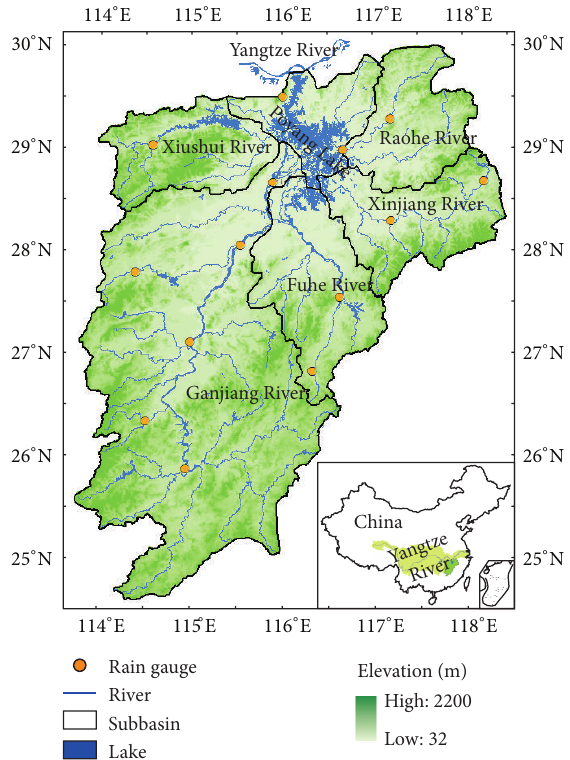
Figure 1: Location of Poyang Lake basin and the distribution of rain